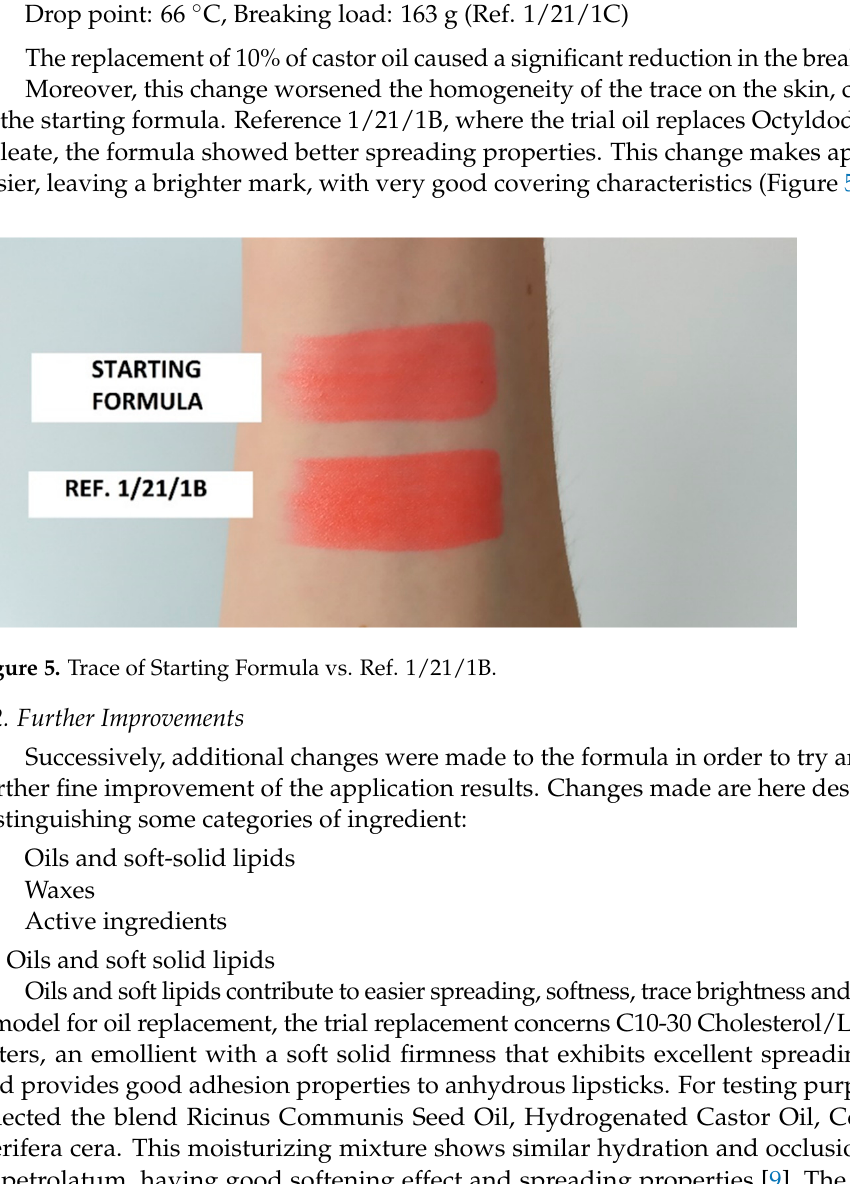
Table 9. Melting points of waxes contained in the